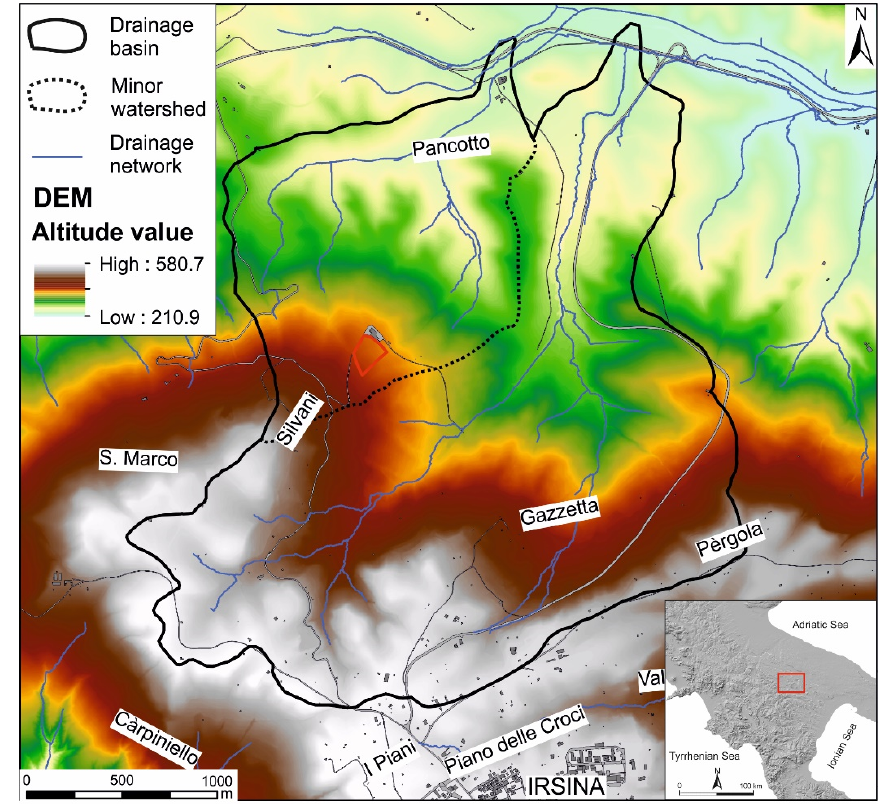
Figure 1. DEM of the study area and drainage network. The red box shows the hazelnut crop. The paths of the hazelnut tree in historical times were varied and do not allow a certain attribution of its origins. The movement of the hazelnut species from east to west, in the presence of a plant which has existed since prehistoric times, was widespread in classical times, as confirmed by the scientific term, which is composed of a Latinized Greek flanked by a Latin term ( Corylus avellana ). The coexistence of two names with different roots is a precise metaphor for the widespread diffusion of the hazelnut tree in the classical world, as evidenced by both historical sources [20,21] and recent studies [22]. Today, the hazelnut is a very ancient plant with a growing market demand and a high degree of adaption to pedological and morpho-climate conditions. Moreover, an analysis of historical sources highlights that hazelnut cultivation is widespread in southern Italy, mainly in landscape sectors affected by land abandonment and degradation. For these reasons,